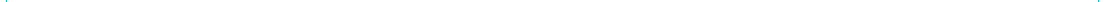
Figure 2: E. coli resistance to various antibiotics stratified for gender, hospital unit, type and location of urine sampling(a) E. coli resistance to various antibiotics stratified by gender(b) E. coli resistance to various antibiotics stratified by urological versus other hospital units: urology in- cludes all urine samples from urological in- and outpatients; all other wards include all other nonurological hospital units (medicine, surgery, gynecology, intensive care unit, haematology, outpatient units). Ciprofloxacin had the highest (odds ration [OR] 2.3, 95% confidence interval [CI] 1.95–2.75), followed by cefepime (OR 1.71, 95% CI 1.16–2.22), ceftriaxone (OR 1.64, 95% CI 1.24–2.17) and amoxicillin (OR 1.52, 95% CI 1.52–1.80), all p ≤0.001.(c) E. coli resistance to various antibiotics stratified by urine samples from indwelling catheters versus all others: all others inlcude midstream urine, single-use catheter urine and urine of unknown origin.(d) E. coli resistance to various antibiotics stratified by in-/outpatients: no significant difference between in- and outpatients for all antibiotics (p ≥0.05)y-axis: percentage of resistance* significant dif- ference with p